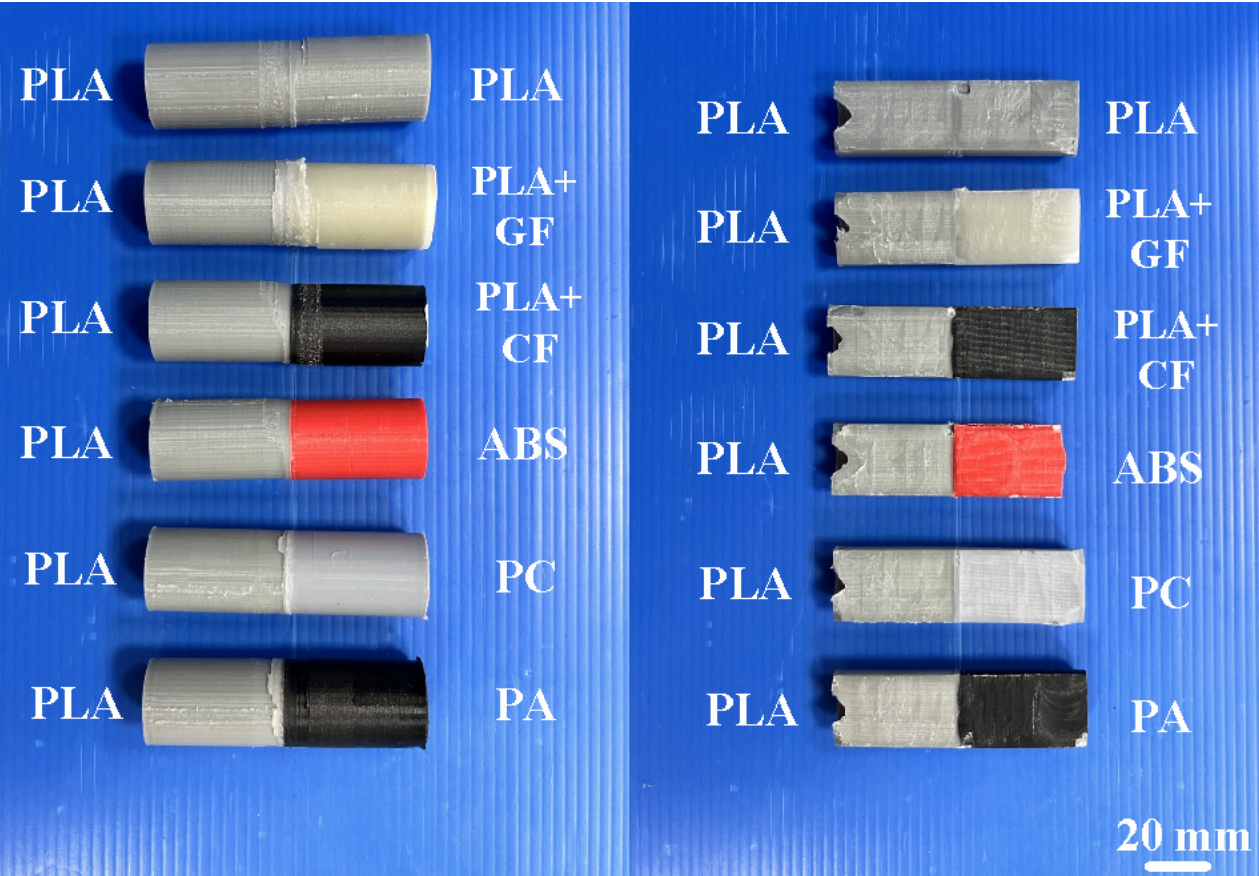
Figure 5. Friction-welded dissimilar polymer rods of whole and half proportions.